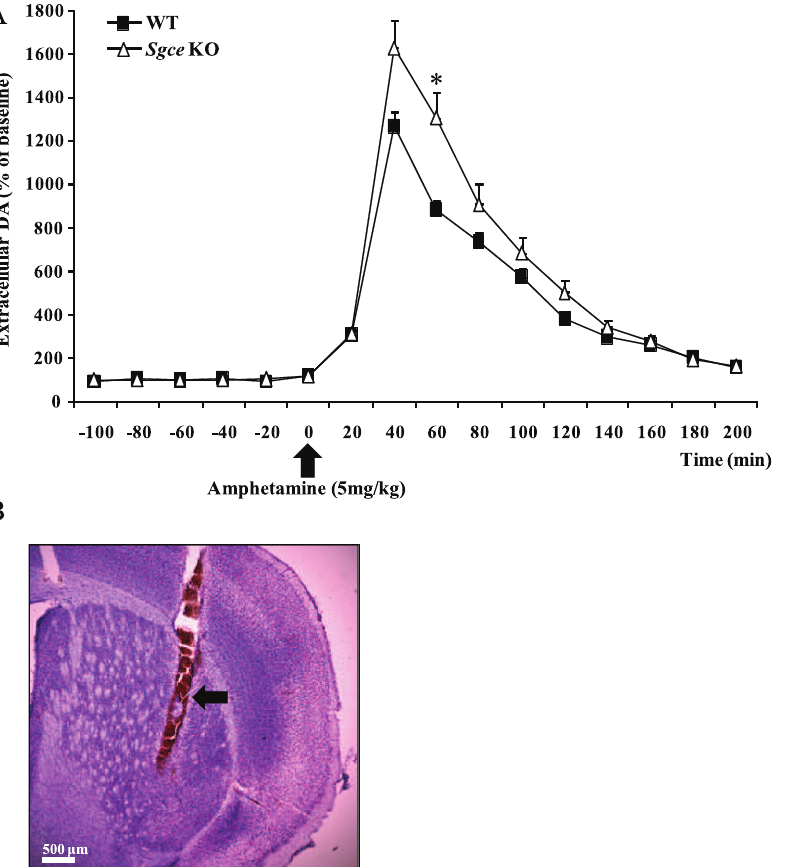
Figure 1. Extracellular dopamine levels in the mouse striatum after amphetamine administration. (A) Amphetamine (5 mg/kg, s.c.) was administrated to conscious mice. Extracellular levels of dopamine in the striatum were measured by in vivo microdialysis. The basal extracellular dopamine levels were 4.013 6 0.267 pg/20 m l (mean 6 SEM of 6 Sgce KO mice) and 4.297 6 0.412 pg/20 m l (mean 6 SEM of 8 WT littermates). The data are the mean 6 SEM of 6 or 8 mice (* p , 0.05). (B) A representative coronal section of the striatum of probe implanted mouse. The black arrow indicates the location of the probe. Scale bar represents 500 m m.